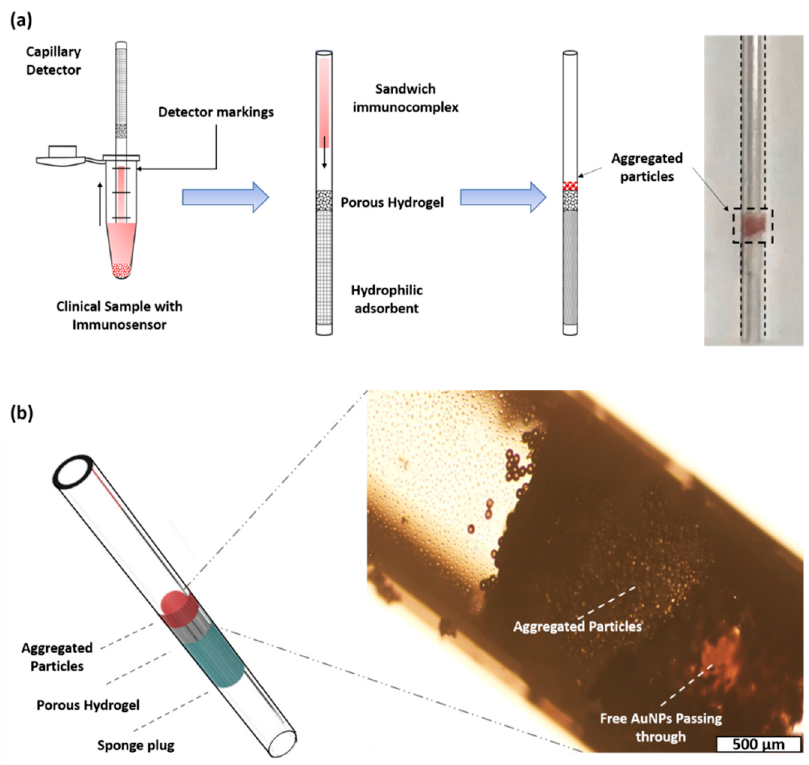
Figure 5. ( a ) Sandwiched immunocomplex detection process; ( b ) 3D model of capillary detector and aggregation of immunocomplex.